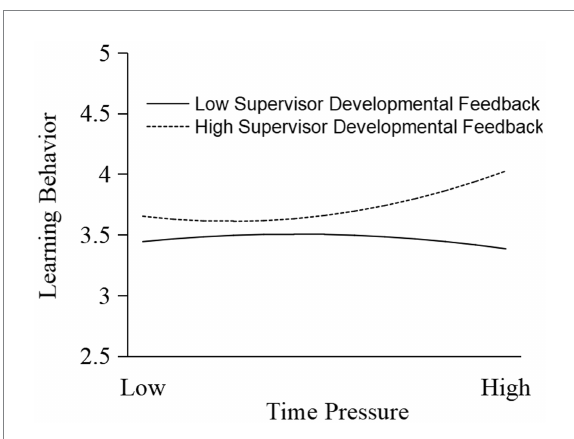
FIGURE 8 Moderating effect of supervisor developmental